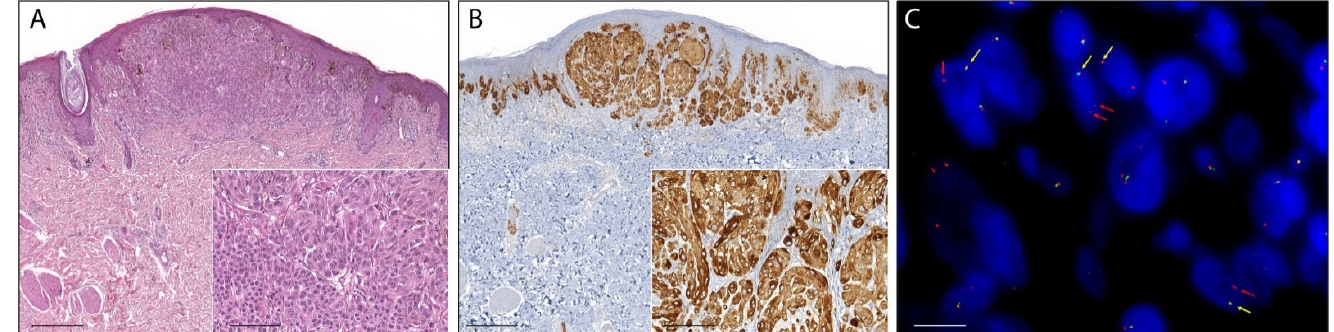
Figure 2. Photomicrographs of an atypical Spitz tumor harboring an NTRK1 fusion. ( A ): The lesion was dome-shaped with epidermal hyperplasia (H&E staining, magnification 40 × , scale bar: 200 µ m). Inset: lobulated nests of epithelioid melanocytes with distinct cell borders and quite pleomorphic nuclei showing a tendency towards maturation that became exaggerated at the bottom of the lesion (H&E staining, magnification 200 × , scale bar: 40 µ m). ( B ): Melanocytes showed strong and diffuse cytoplasmic immunoreaction (pan-TRK immunostaining, magnification 40 × , scale bar 200 µ m). Inset: pan-TRK cytoplasmatic immunoreaction (pan-TRK immunostaining, magnification 200 × , scale bar 40 µ m). ( C ): Break-apart FISH analysis confirmed NTRK1 rearrangement showing the atypical pattern: one fusion signal (yellow arrows) and a single orange signal 3 (cid:48) (red arrows) (ZytoLight SPEC NTRK1 Dual Color Break Apart Probe, original magnification 1000 × , scale bar 5 µ m). Table 1. Demographic, clinical and immunohistochemical data of the atypical Spitz tumors with positive pan-TRK